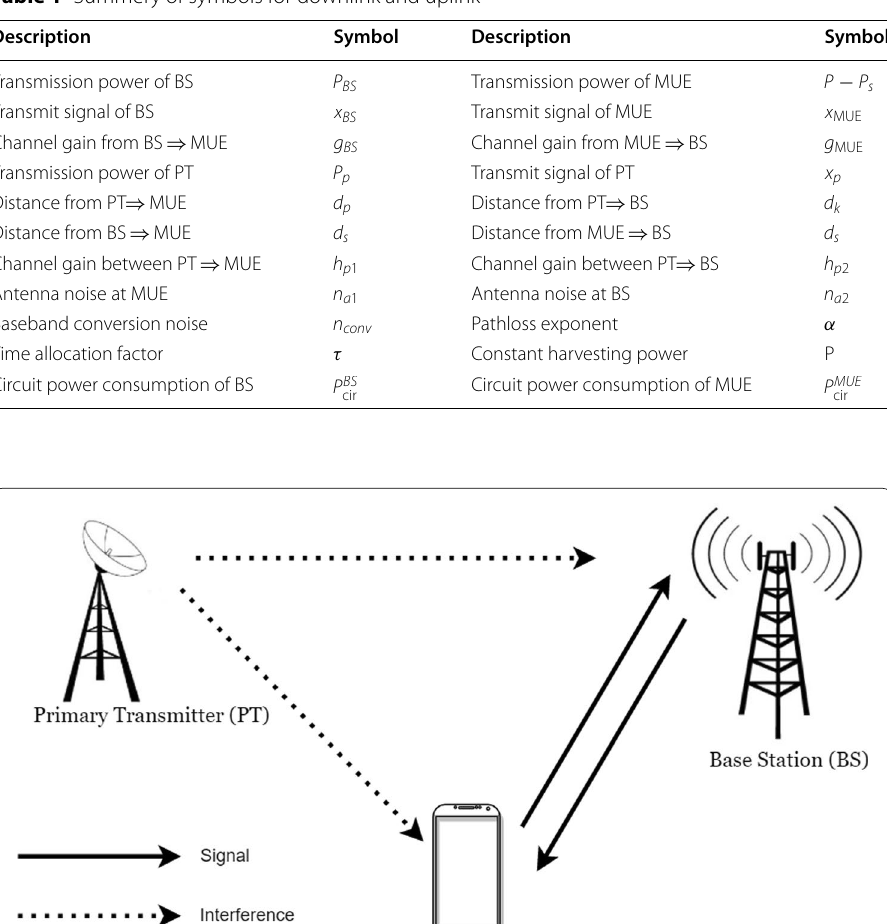
Table 1 Summery of symbols for downlink and uplink